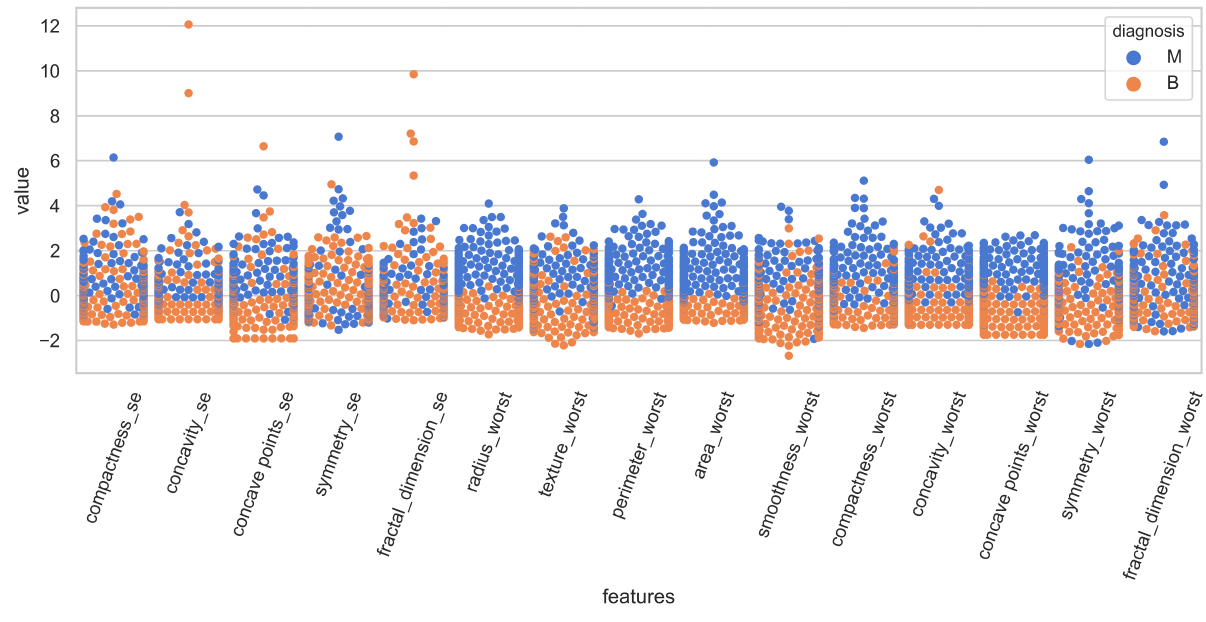
Figure 2. Representation of attributes 15–30 with respect to